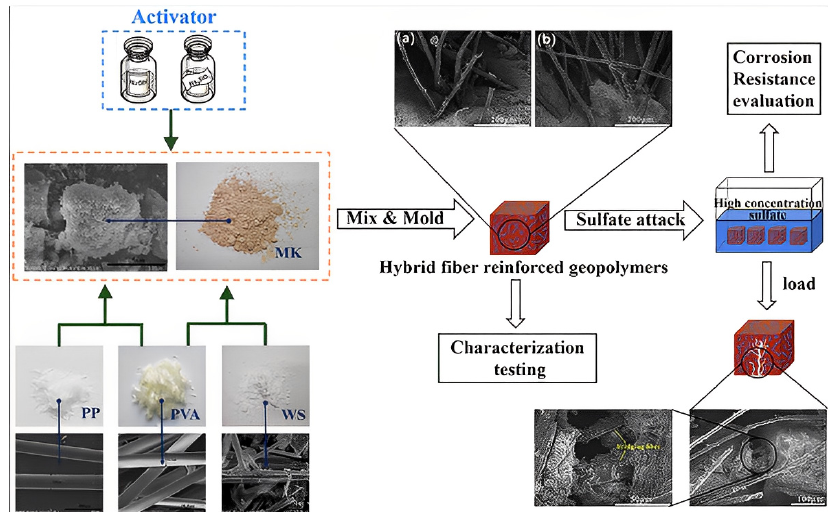
Figure 4. Mixing Stages of Geopolymer Concrete [98]. (Reprinted with permission from the pub- lisher, Elsevier; License No. 547171104179).